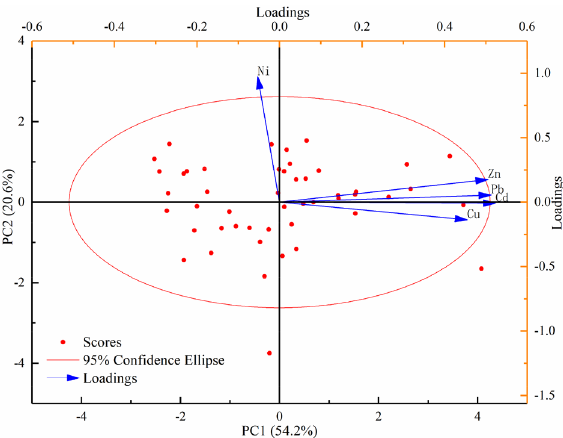
Figure 14. Principal component analysis on factor